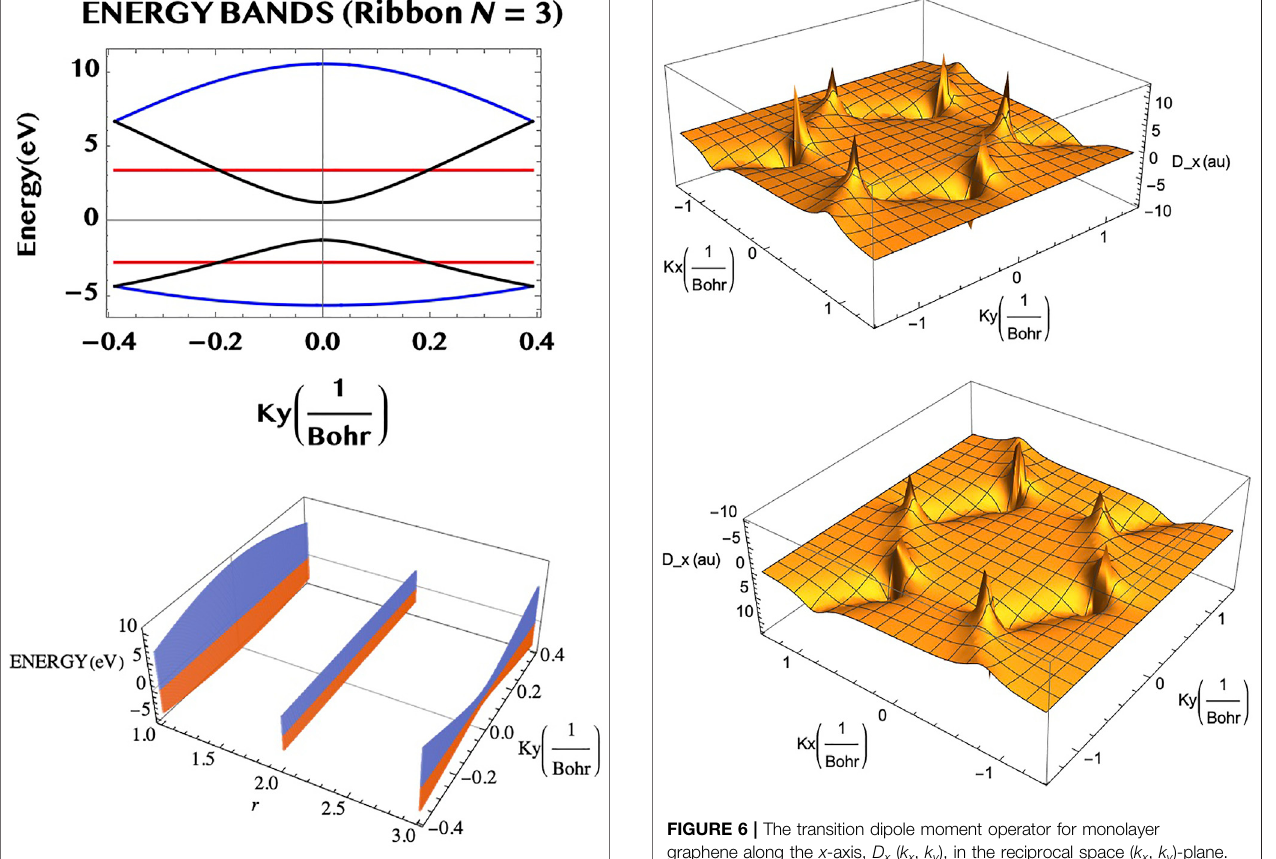
Frontiers in Chemistry |